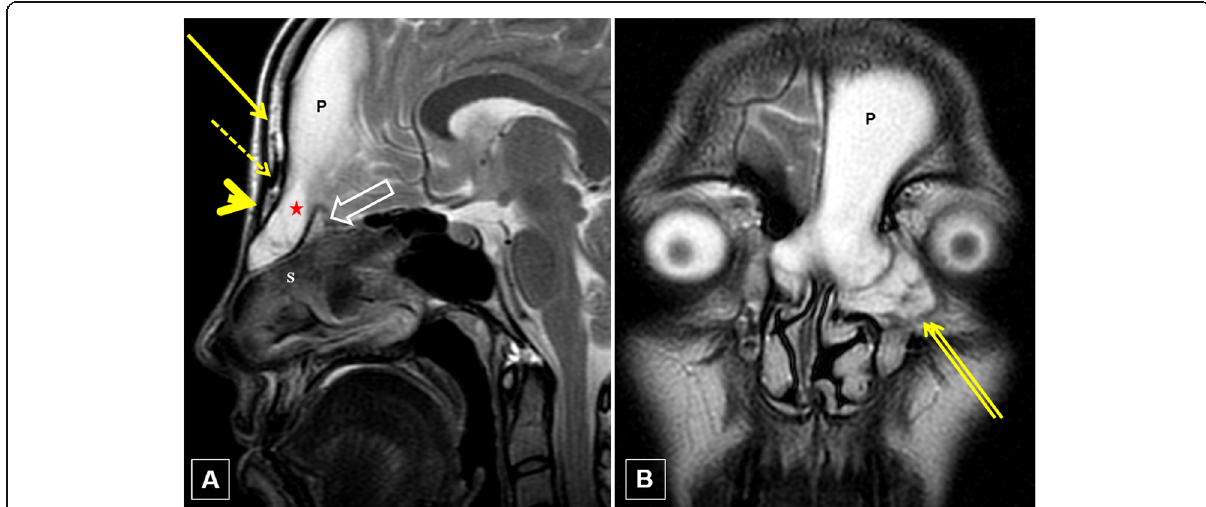
Fig. 4 Nasoethmoidal and nasoorbital encephalocele. a (T2-weighted sagittal) image shows herniation of the brain content into the prenasal space through foramen cecum (star) anterior to crista galli (open arrow). Prenasal space is bounded anteriorly by nasal bone (arrowhead) and posteriorly by nasal septum (S). Nasofrontal suture (dotted arrow) is seen between frontal bone (long arrow) and nasal bone (arrowhead). Note that the herniated content has undergone gliosis appearing hyperintense on T2-weighted images with a porencephalic cyst in the adjacent frontal lobe (P). b (T2-weighted coronal) image: Note the nasoorbital extent of this herniated sac (double arrow)